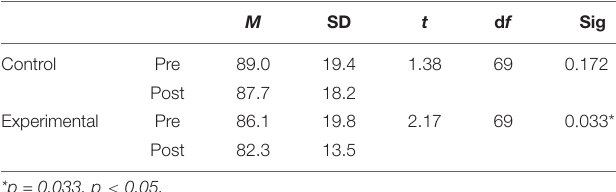
TABLE 2 | English Language Learning Anxiety Scale paired sample T -test results.